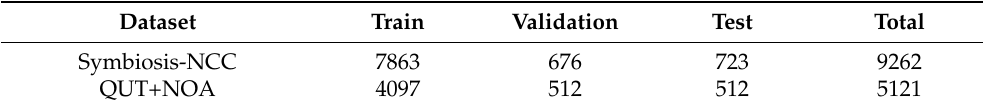
Table 6. Split of the datasets used for the Binary–No mix classification of Table 8. In the Symbiosis-NCC dataset, segments from the same video are in the same set (among train, validation and test).